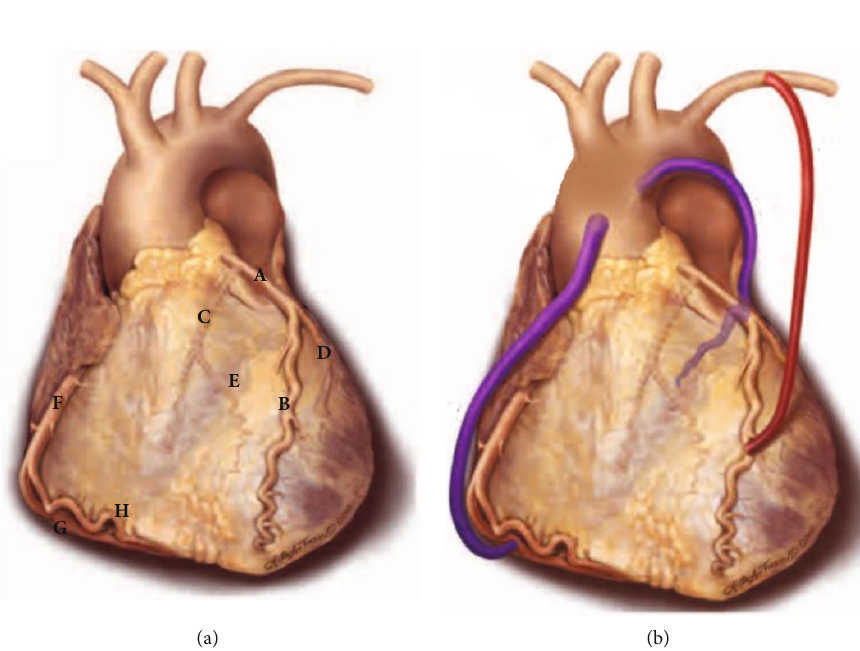
Figure 5: (a) Normal anatomy of the coronary arteries: (A) left coronary artery, (B) left anterior descending artery, (C) left circum fl ex artery, (D) diagonal artery, (E) obtuse marginal branch of the left circum fl ex artery, (F) right coronary artery, (G) posterior descending artery, and (H) acute marginal branch of the right coronary artery. (b) Left internal mammary artery graft from its origin at the subclavian artery proximally and grafted to the left anterior descending artery distally (in red) [4]. This fi gure is reproduced from Frazier, A., Qureshi, F., Read, K. M., Gilkeson, R. C., Poston, R. S., & White, C. S. (2005). Coronary Artery Bypass Grafts: Assessment with Multidetector CT